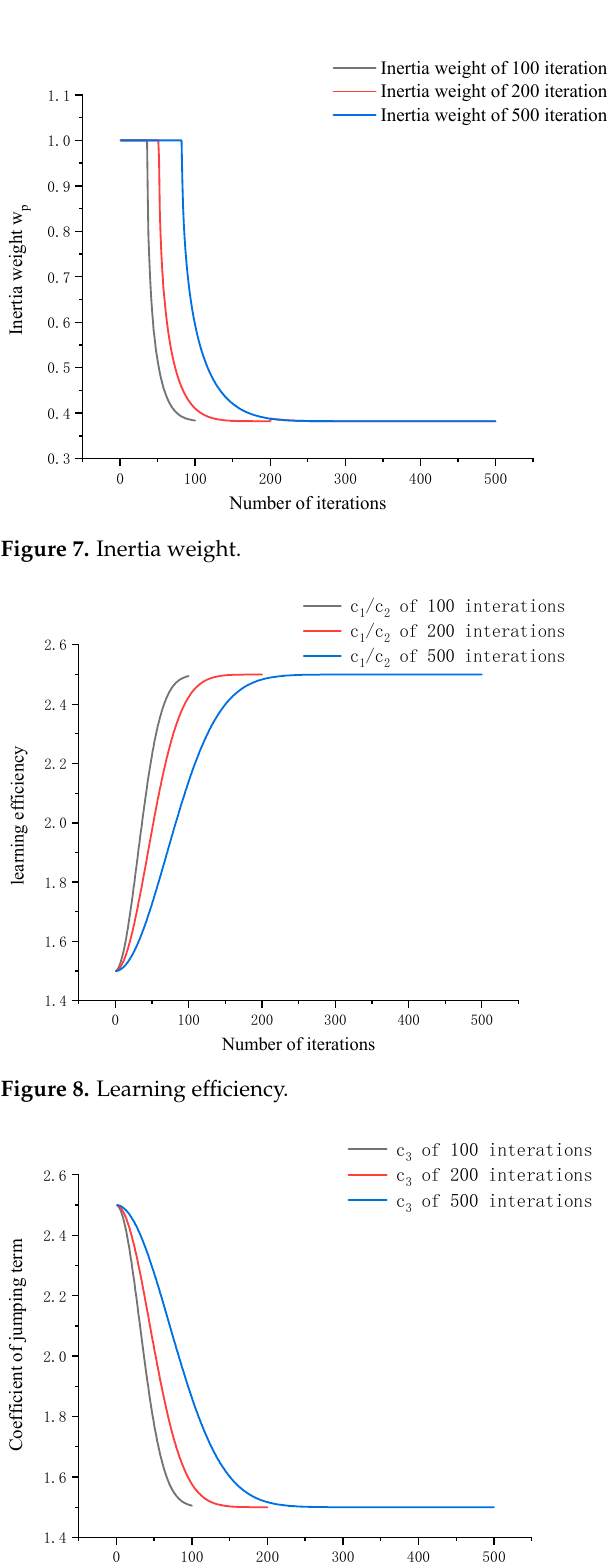
Figure 6. Fitness of EPA-PSO algorithm.